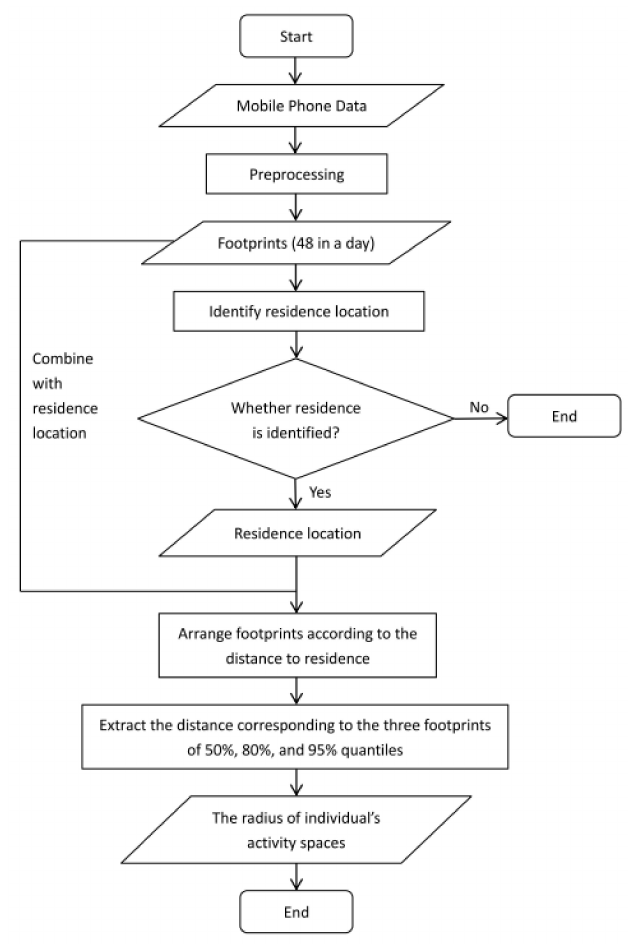
Figure 4. The flow of identifying an individual’s activity